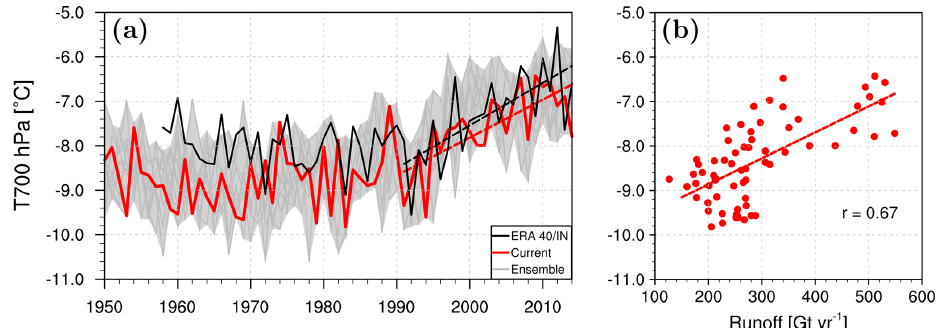
Figure 4. (a) Time series of the annual June–July–August (JJA) atmospheric temperature at 700hPa ( T 700 ) averaged over 60–80 ◦ N and 20–80 ◦ W for the ERA-40 (1958–1978) and ERA-Interim (1979–2014) reanalyses (black), the current CESM2 simulation (red) and 11 additional reference ensemble members (dark grey). The grey belt encompasses annual minimum and maximum values of the whole en- semble. (b) Annual GrIS-integrated runoff derived from CESM2-forced RACMO2.3p2 at 1km resolution as a function of JJA atmospheric temperature at 700hPa from the current CESM2 simulation